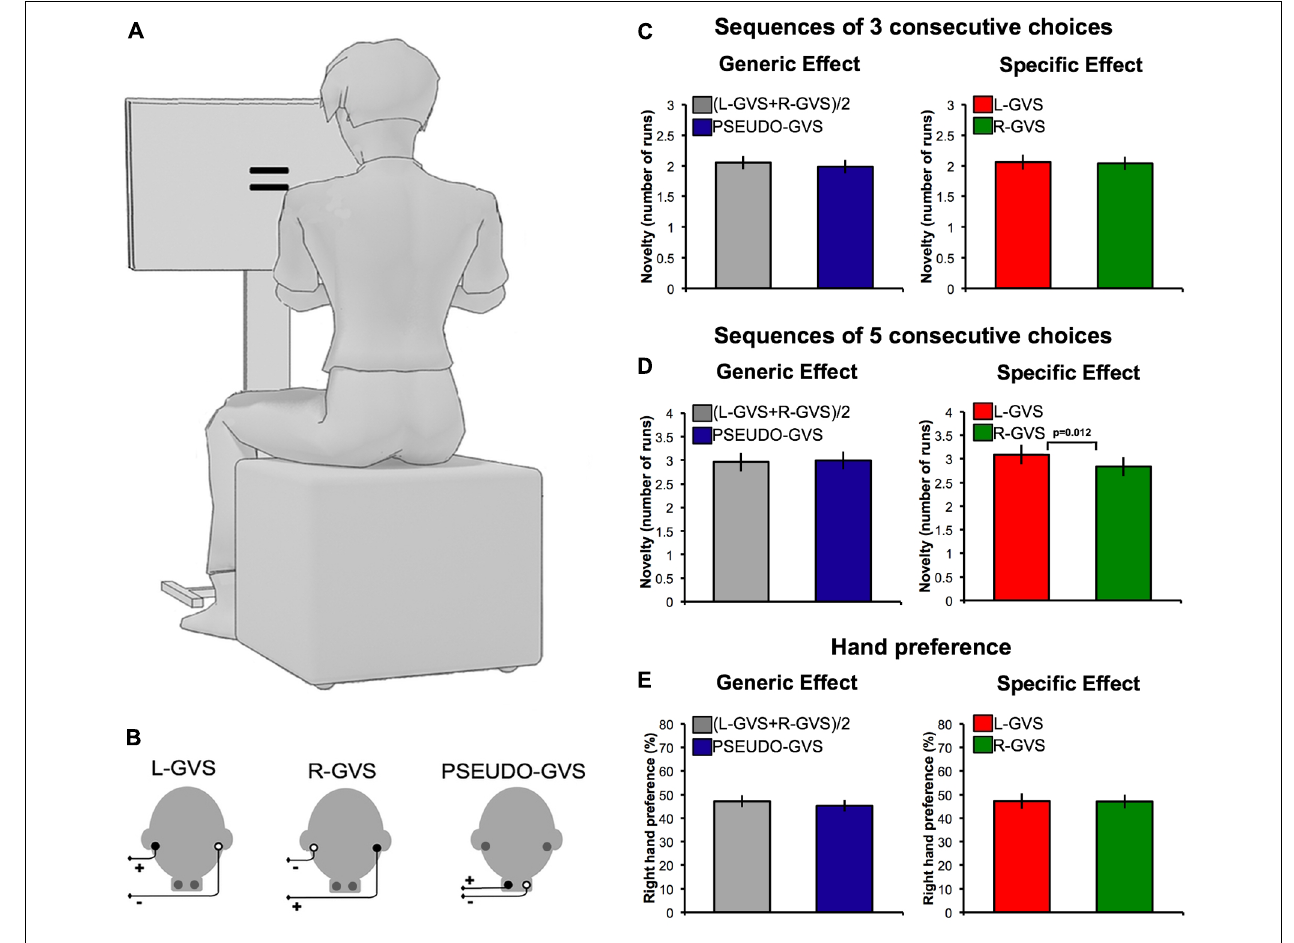
FIGURE 1 | Effects of GVS on spatial bias and novelty. (A) Experimental set-up. (B) GVS polarities and electrodes configurations. (C) Number of runs in sequences of three successive free-choices in each experimental